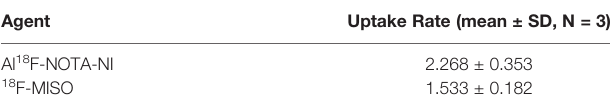
TABLE 1 | Hypoxia/normoxia uptake ratios of Al 18 F-NOTA-NI and 18 F-MISO ( p < 0.05). Agent Uptake Rate (mean ± SD, N =